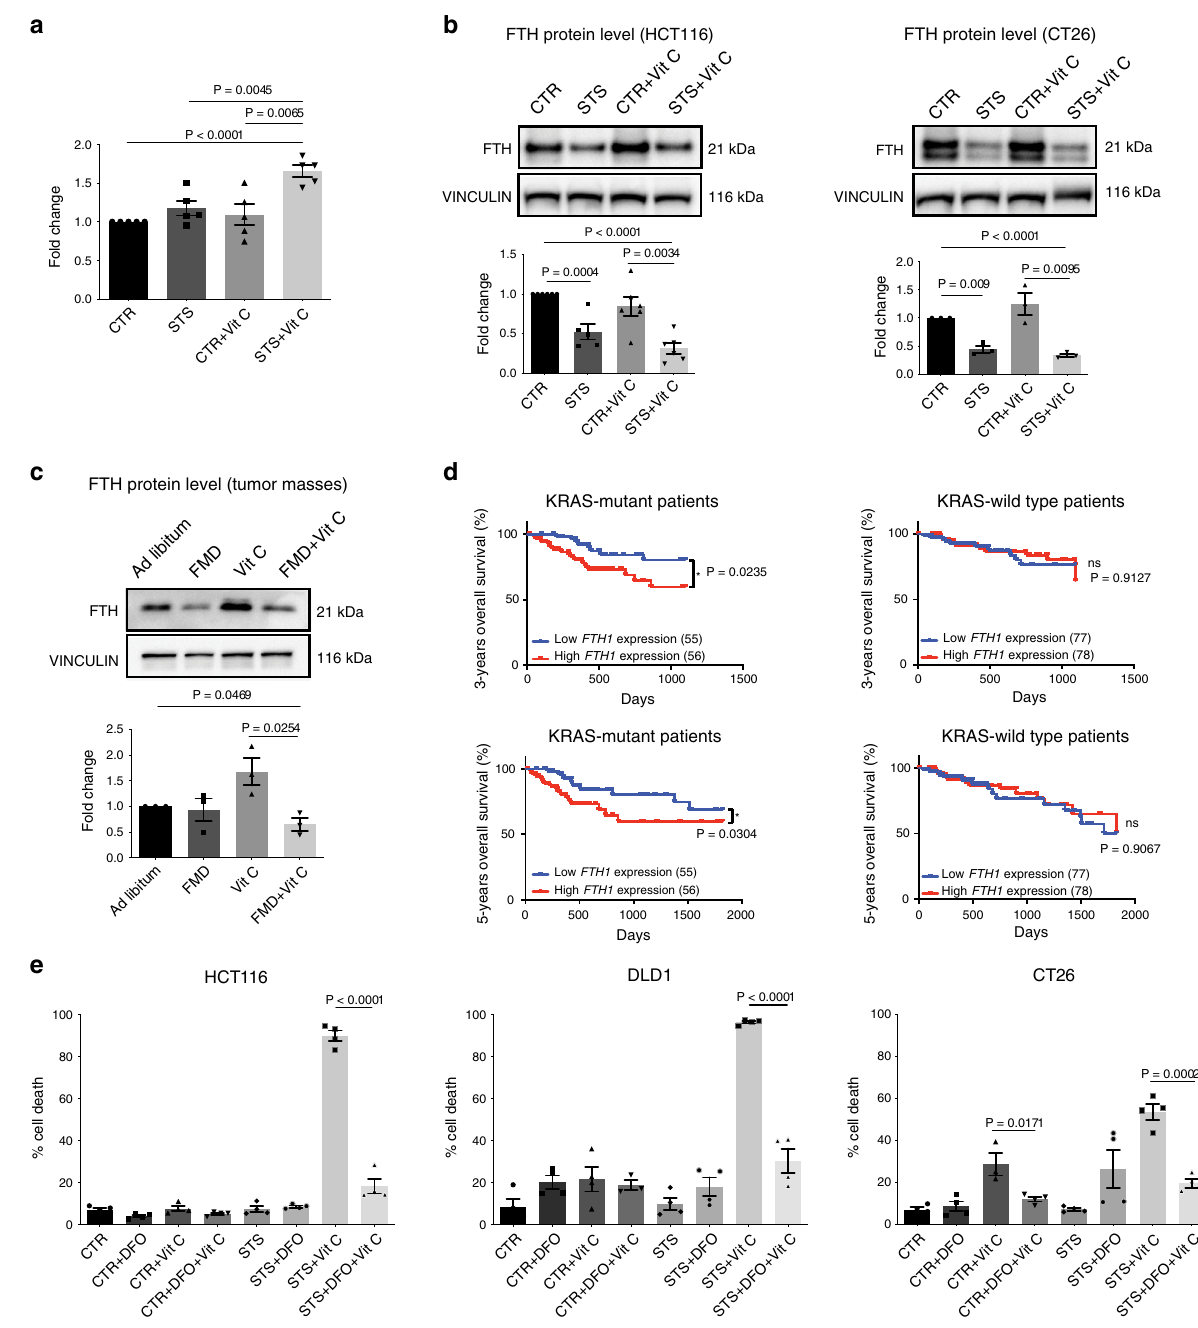
Fig. 3 Iron is involved in FMD + vitamin C toxicity selectively in KRAS mutated cancer cells. a Intracellular free iron (Fe 2 + ) measurement, relative to CTR cells, of HCT116 treated with STS with or without vitamin C ( n = 5). P values were determined by two-sided unpaired t -test. Exact P value = 0.00002 (CTR vs STS + Vit C). b Detection of ferritin (FTH) protein expression by western blot in HCT116 ( n = 6, n = 5 in STS), CT26 cells ( n = 3) and c HCT116-derived tumor masses ( n = 3). VINCULIN as loading control. P values were determined by two-sided unpaired t -test. HCT116 exact P value = 0.000002 (CTR vs STS + Vit C); CT26 exact P value = 0.00002 (CTR vs STS + Vit C). d Three-year (left panel) and 5-year (right panel) overall survival of patient bearing KRAS -mutant (left) and KRAS -wild-type (right) tumors collected from The Cancer Genome Atlas Database (TCGA) and strati fi ed according to intratumor FTH1 mRNA expression levels. P values were determined by Wilcoxon matched-pairs signed rank test. e Viability of HCT116, DLD1 and CT26 cells in response to STS, vitamin C, or their combination with or without desferrioxamine (DFO) ( n = 4, n = 3 in DLD1- CTR + DFO + Vit C and CT26- CTR + Vit C). P values were determined by two-sided unpaired t -test. HCT116: exact P value = 0.000003 (STS + Vit C vs STS + DFO + Vit C); DLD1: exact P value = 0.00003 (STS + Vit C vs STS + DFO + Vit C). All data are represented as mean ± SEM, n = independent